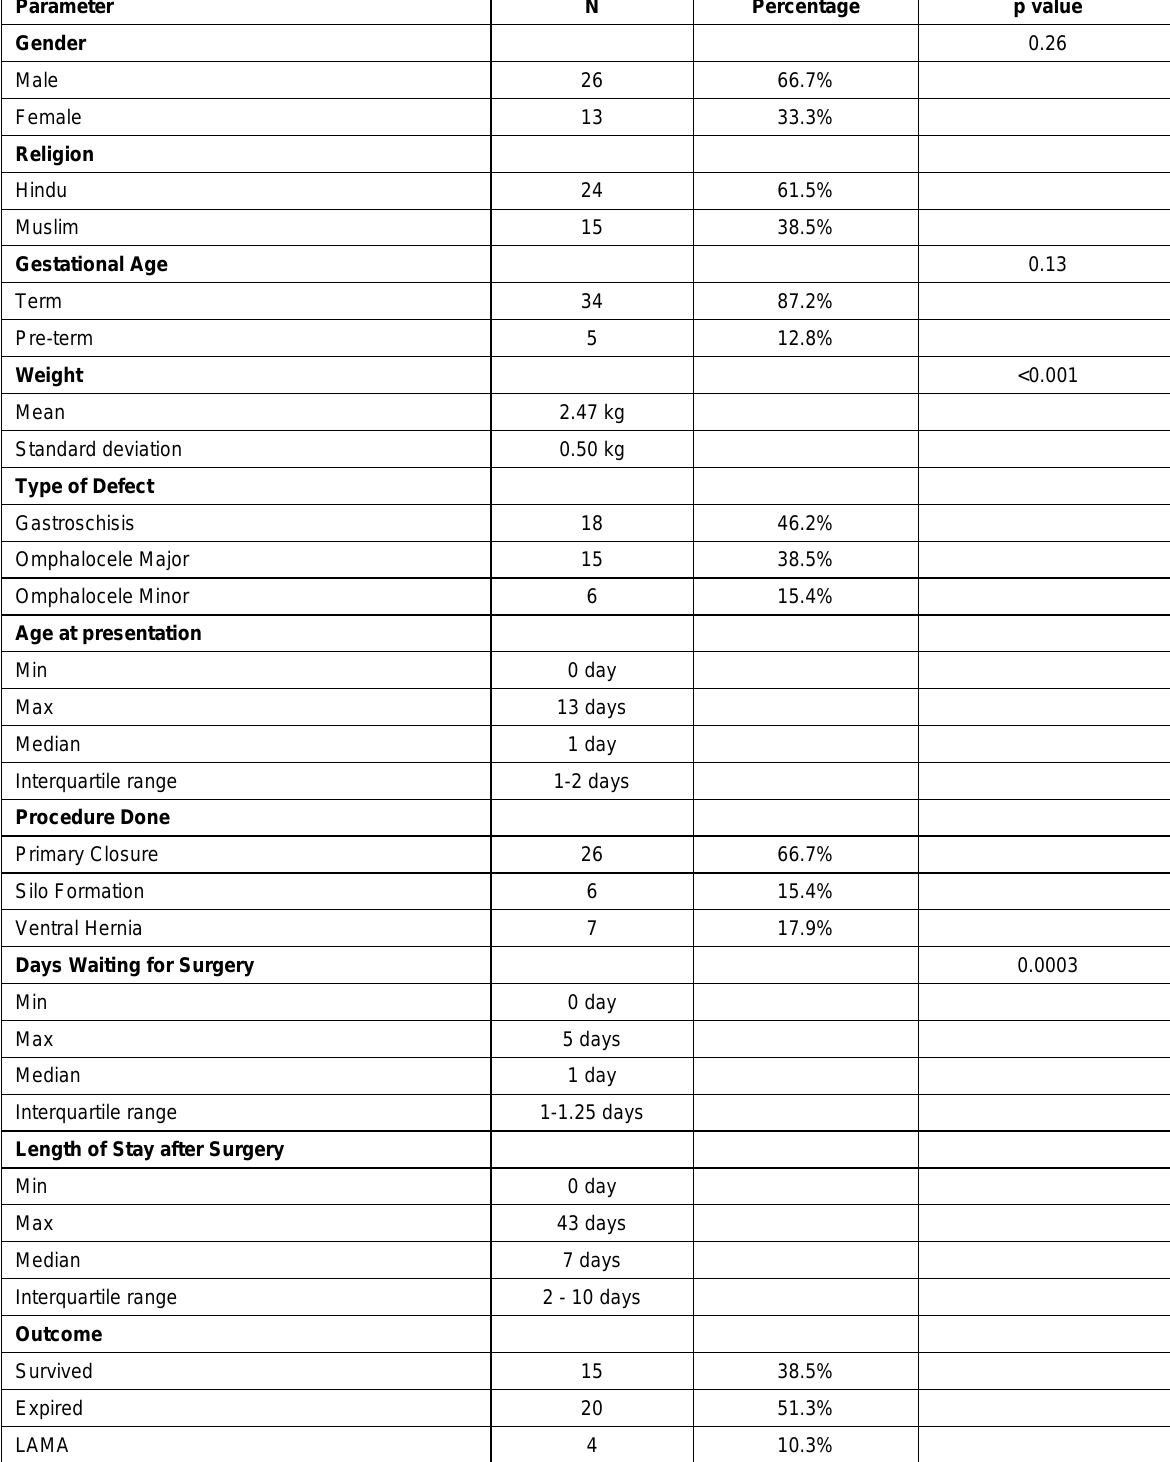
Table 1: Demographic and clinical profile of patients operated for anterior abdominal wall defects